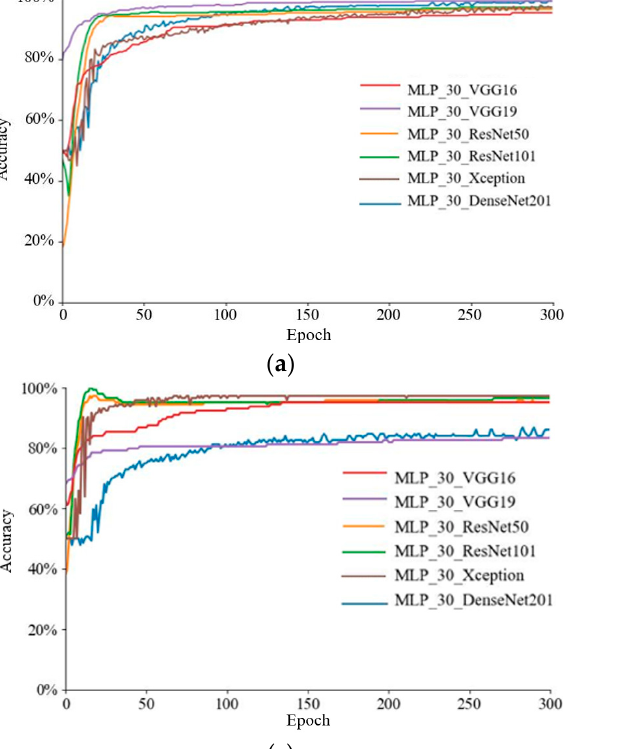
Figure 9. Training curves for six fusion models: ( a ) training accuracy curve; ( b ) training loss curve; ( c ) validation accuracy curve, and ( d ) validation loss curve.